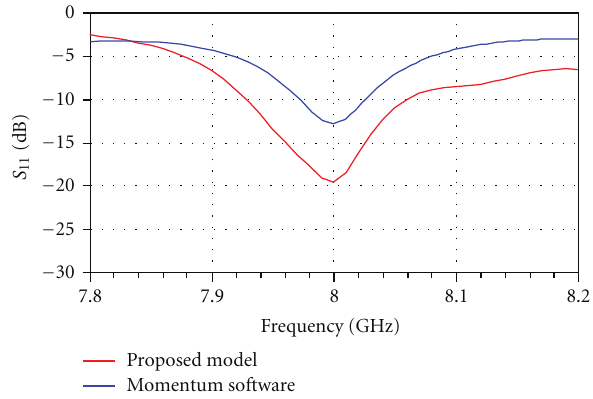
Figure 15: Simulated input antenna array return